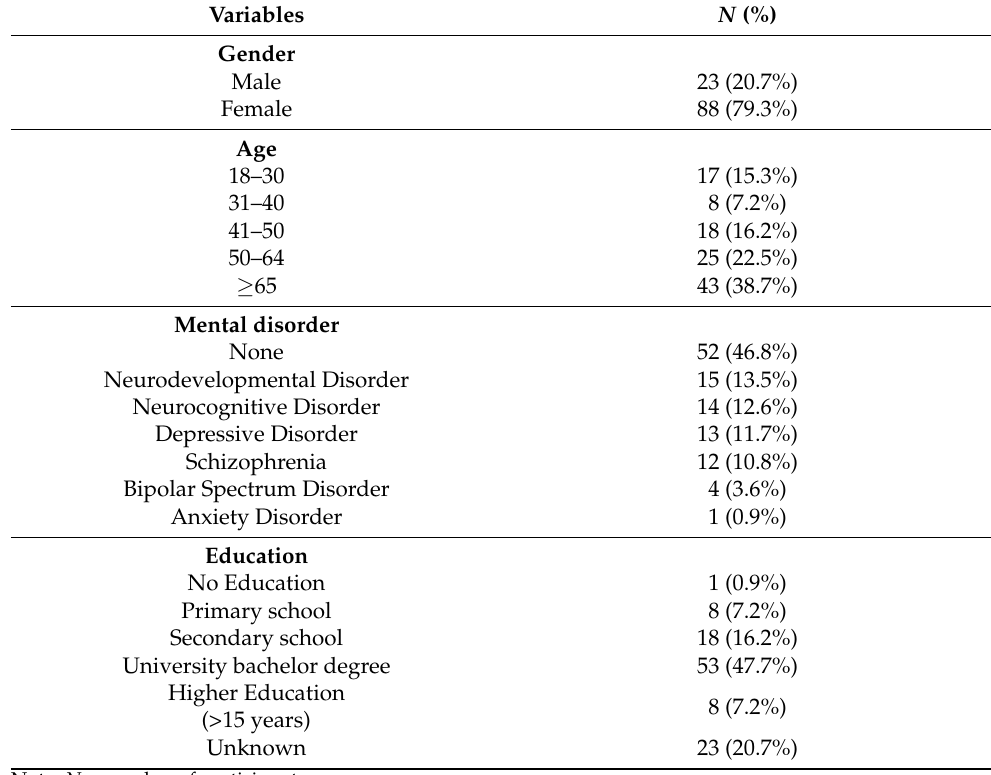
Table 1. Participants Characteristics ( N =